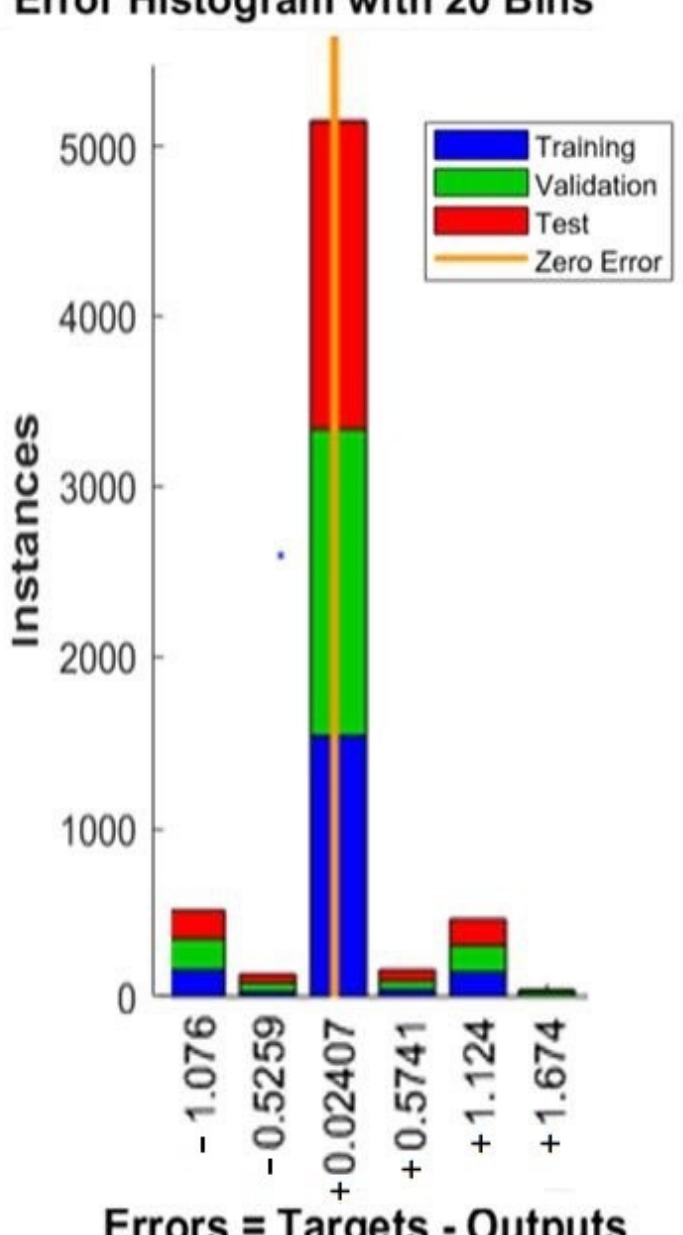
Figure 3. Error histograms with the lowest error values (error values close to 0).